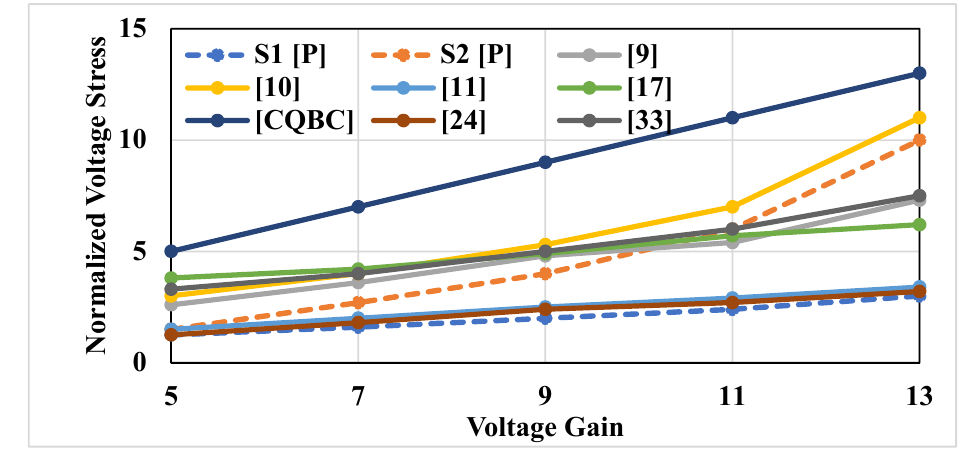
Figure 7. Normalized voltage stress vs. Voltage gain.